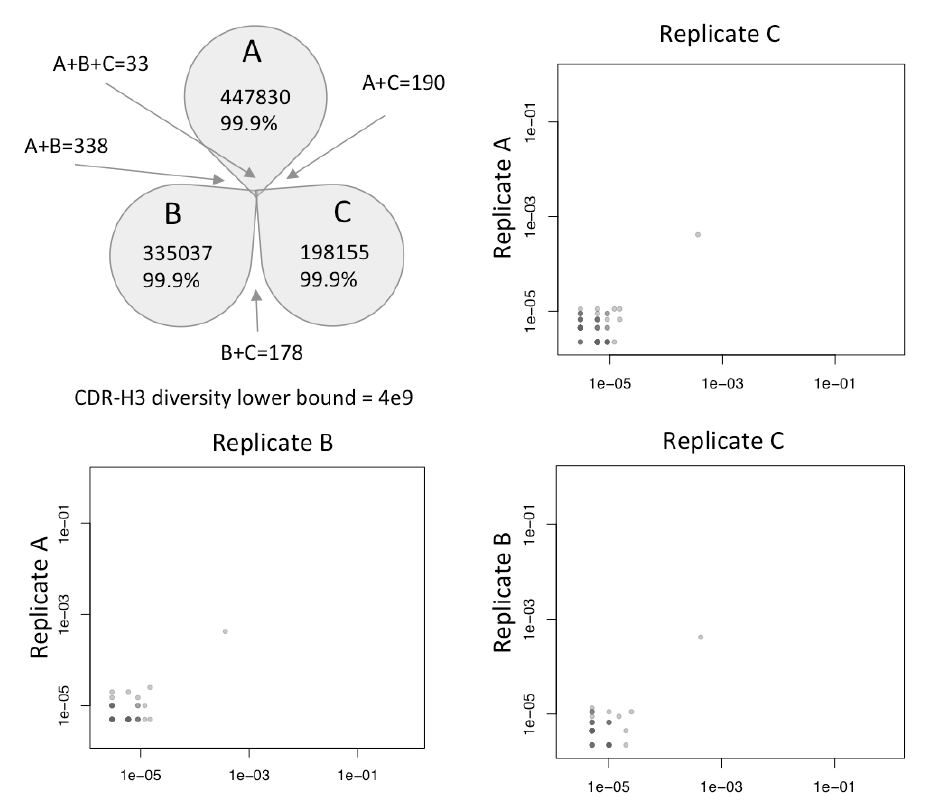
Figure 6. Synthesized molecular diversity of V HH CDR-H3. Three replicates were sequenced to depths of 447830, 335037 and 198155 reads, respectively. Over 99.9% of all reads in each replicate were unique and specific to the replicate in which they were generated, with only 33 clones observed across all three replicates at this depth of sequencing. A minimum CDR3 diversity of 4 billion unique CDR3s is calculated by capture-recapture. Plots show clone frequency overlap between replicates. A single 5e-3 enrichment control clone is observed in all libraries, with shared clones becoming evident with frequencies 1e-5 or